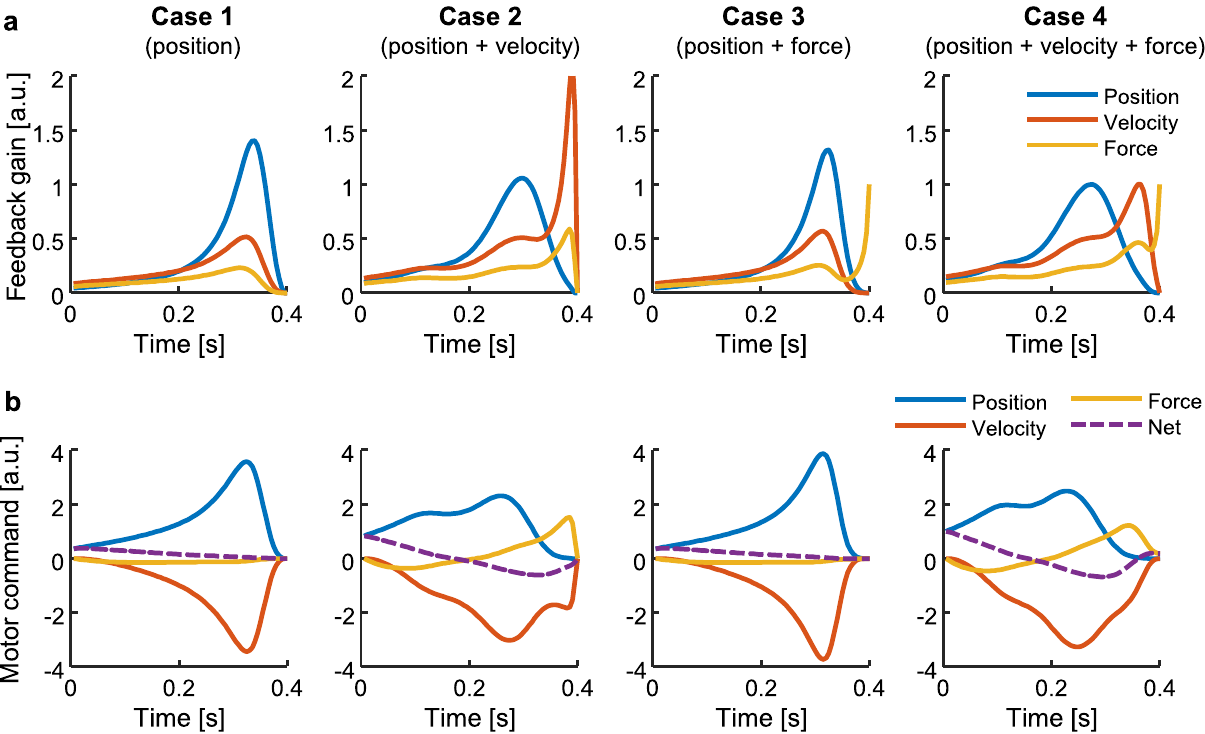
Figure 7. Typical feedback gains of the optimal feedback control (OFC) model and the contributions to motor command. The optimal feedback gains were analytically computed for a linear system to model hand movements as mass-point dynamics. Each case (Cases 1–4) corresponds to the same formation of the cost function in the above results. ( a ) Feedback gains. Each value of the position, velocity, and force gains was normalised to the values of Case 4. ( b ) Contributions of the feedback terms to the net motor command. Each value was normalised to the net motor command of Case